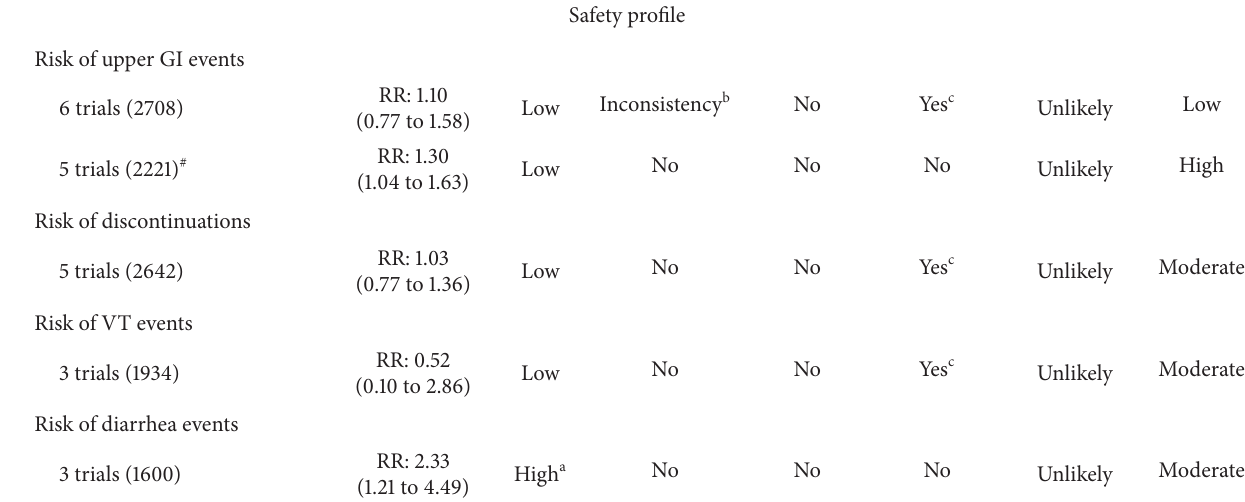
Table 3: $ GRADE evidence profile: randomized controlled trials of comparison between Aln and Rlx for postmenopausal women. No. of trials (No. of women) Antifracture